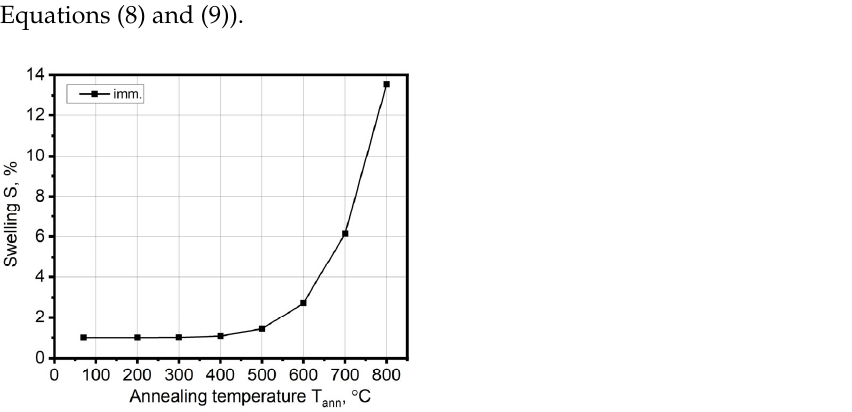
Figure 2. Dependence of swelling S of beryllium irradiated at 70 °C on annealing temperature (for 1 h), reactor SM-3, F = 2.8 · 10 22 cm − 2 (E > 1 MeV).